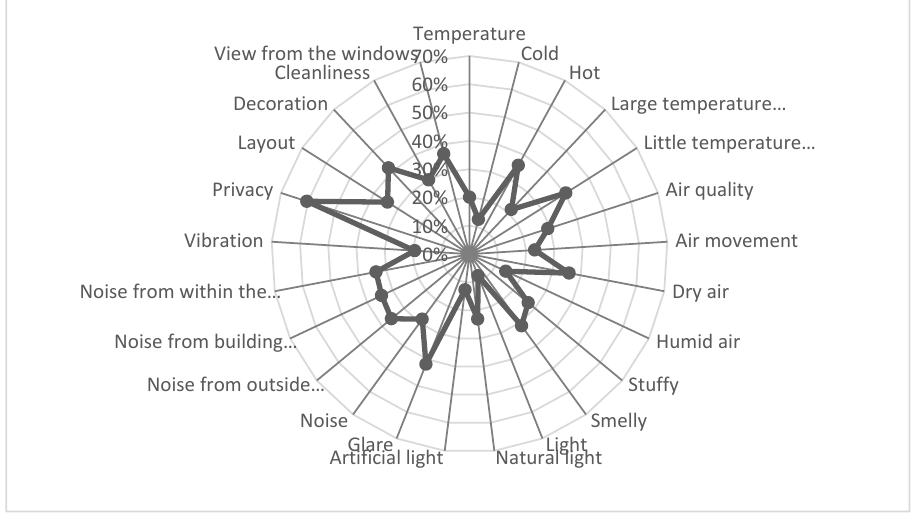
Figure 3. Dissatisfaction with IEQ-aspects (%).